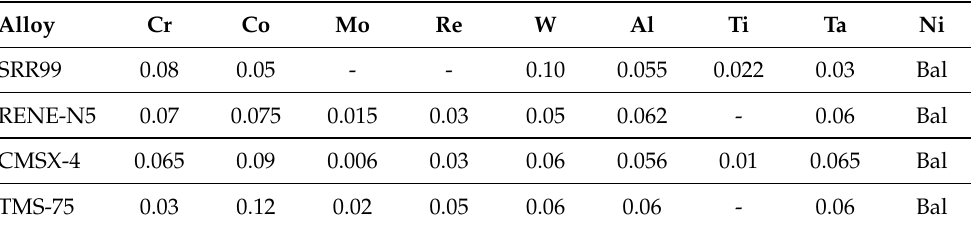
Table 1. Nominal chemical composition (mass fraction) for four generations of single-crystal nickel- based superalloys.